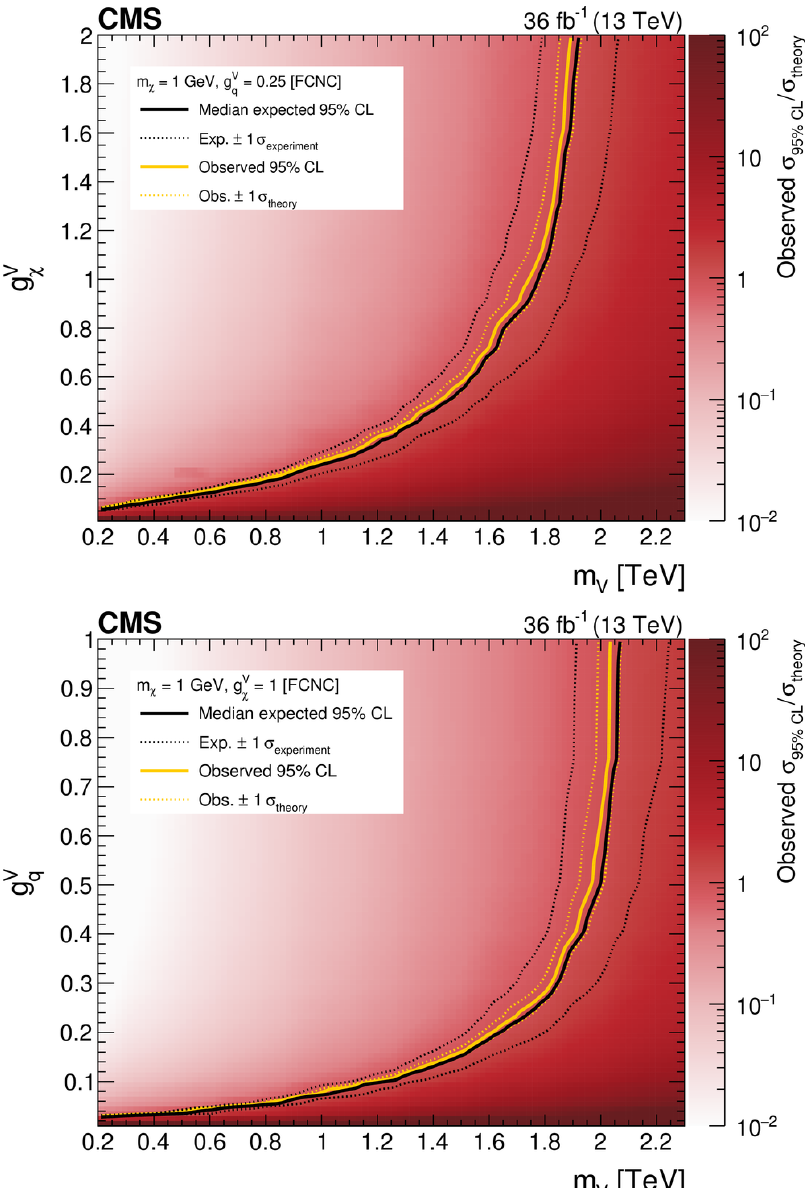
Figure 11 . Results for the FCNC interpretation presented in the two-dimensional plane spanned by the mediator mass and the coupling between the mediator and DM (upper) or quarks (lower). The mediator is assumed to have purely vector couplings. The observed exclusion range (gold solid line) is shown. The gold dashed lines show the cases in which the predicted cross section is shifted by the assigned theoretical uncertainty. The expected exclusion range is indicated by a black solid line, demonstrating the search sensitivity of the analysis. The experimental uncertainties are shown in black dashed lines.